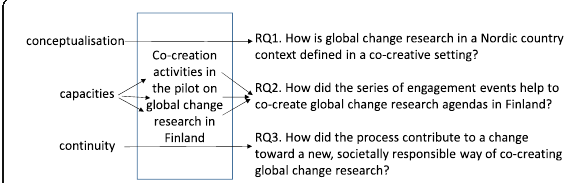
Fig. 2 The analytical model applied in this study